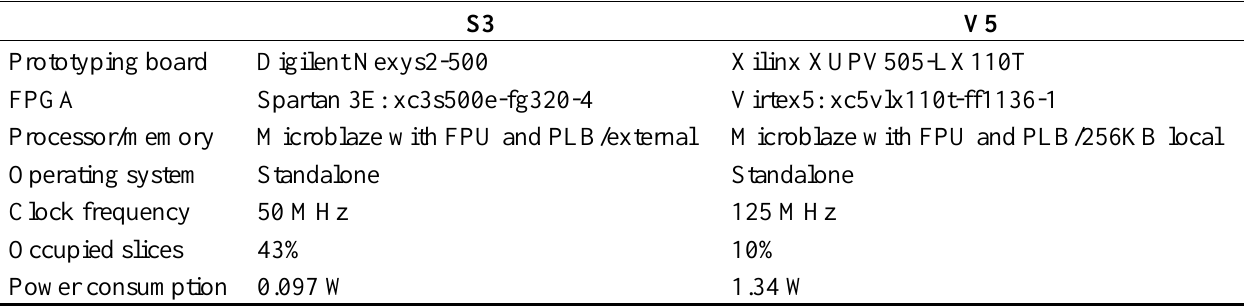
Table 1. Main characteristics of the implemented architecture.